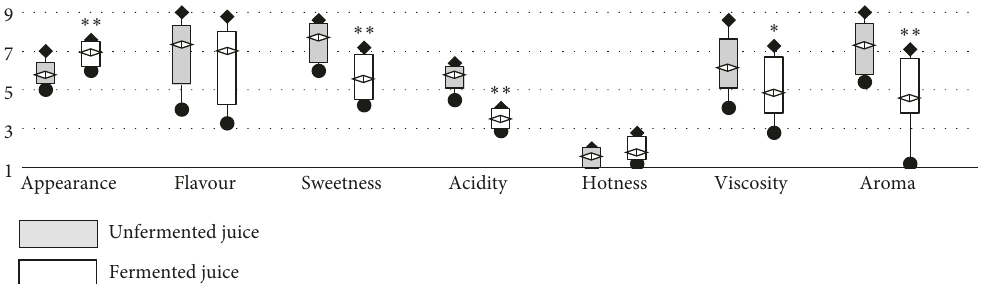
Figure 3: Sensory score of the unfermented and fermented juice. mean of the score. The histogram is the distribution of the score except the maximum and the minimum. difference between the mean of the unfermented juice and fermented juice at levels 0.05 and 0.01,